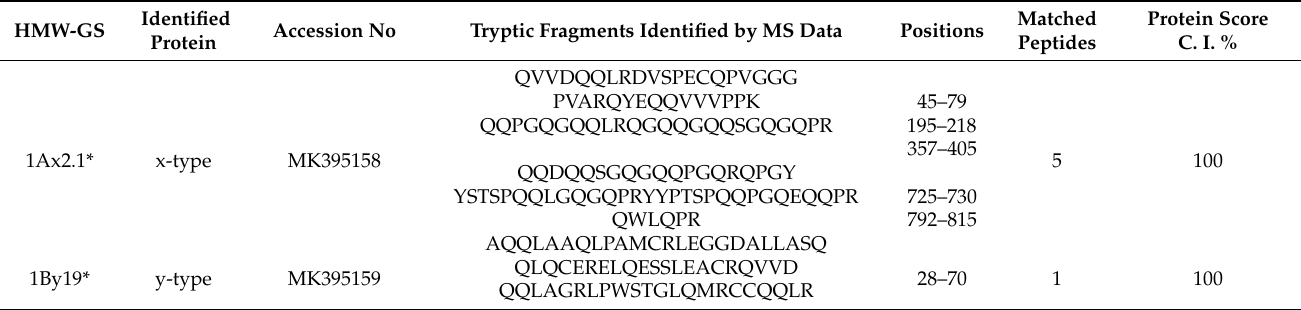
Table 2. Identification of 1Ax2.1* and 1By19* subunits by